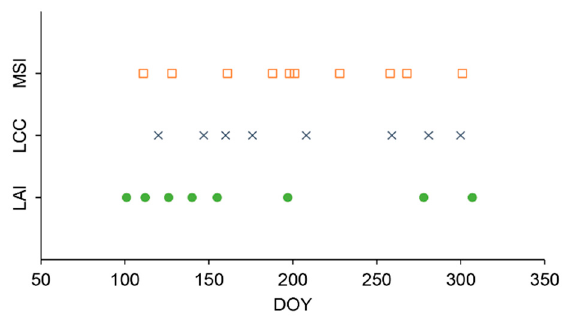
Figure 2. Field data collection of leaf area index (LAI) and leaf chlorophyll concentration (LCC), in addition to MSI data availability throughout the study period.